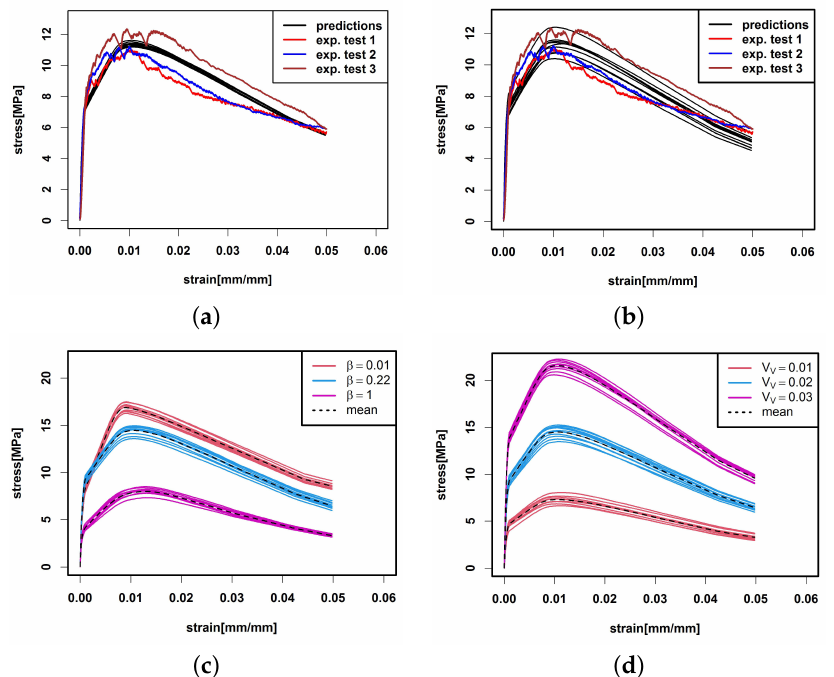
Figure 10. Prediction of M = 10 tensile curves ( a ) based on the CT scanned fibre system summarised in Table 3, ( b ) tensile prediction of 10 virtual specimens with fibre system generated by the stochastic fibre model from Section 2.6 with input parameters determined from the scanned fibre system. The predictions are compared with the three experimental tensile curves. ( c ) and ( d ) Tensile prediction of 10 virtual specimens with varied parameters. ( c ) β = 0.01,0.22,1 is varied and V V is fixed. ( d ) β is fixed and V V = 0.01,0.02,0.03 is varied. The mean of the tensile predictions per varied parameter is given as a dotted